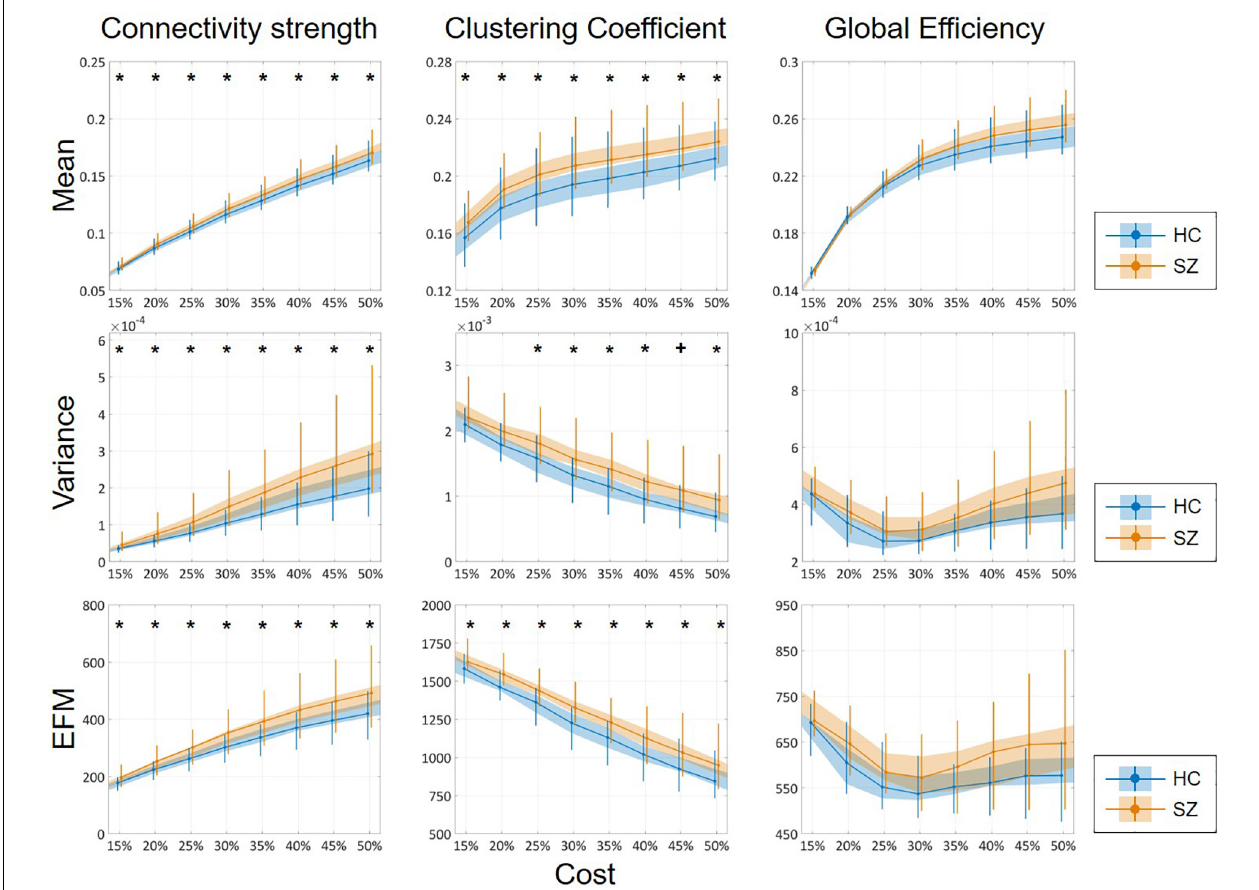
FIGURE 4 | Cost-dependent results of the mean, variance and excursions from median analysis of network measures. Mean, variance, and excursions of median (EFM) values of the three network measures are plotted as functions of the cost. Black markers indicate significant group level difference ( p < 0.05, corrected). * Two-sample t -test; + Mann–Whitney U -test; HC, healthy control; SZ, schizophrenia.